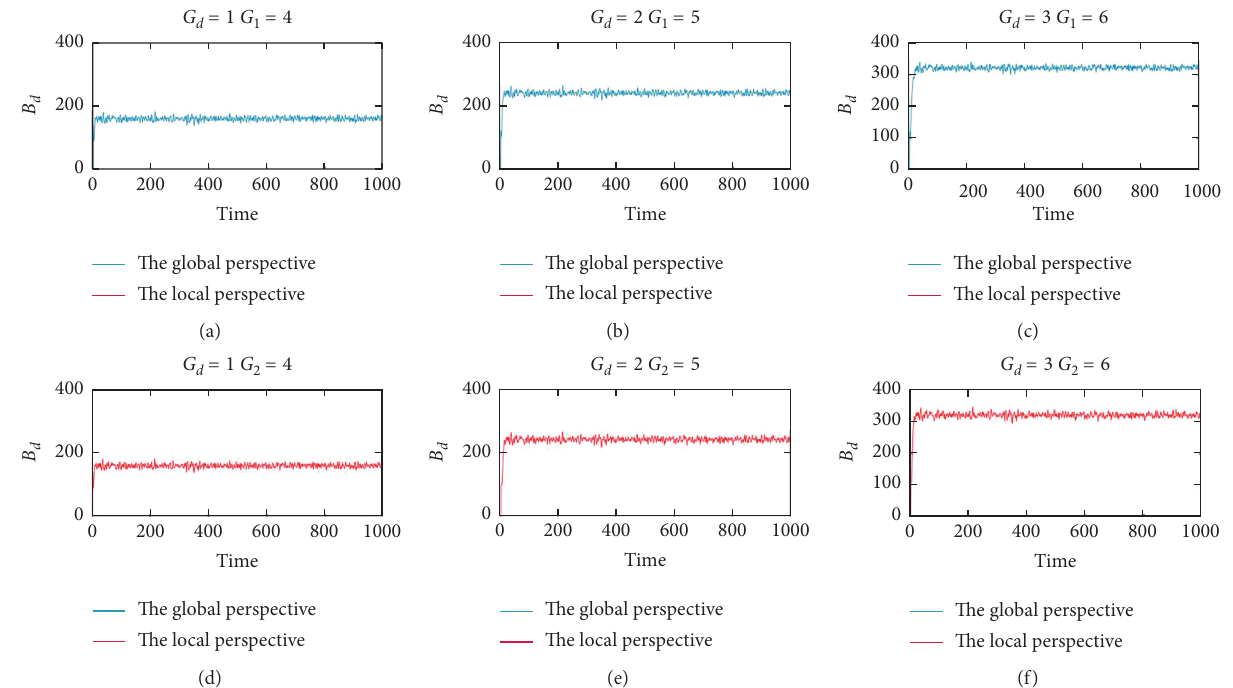
Figure 22: The initial inventory changes of the distribution center in a stable state under the scenario of random demand obeying normal distribution from different